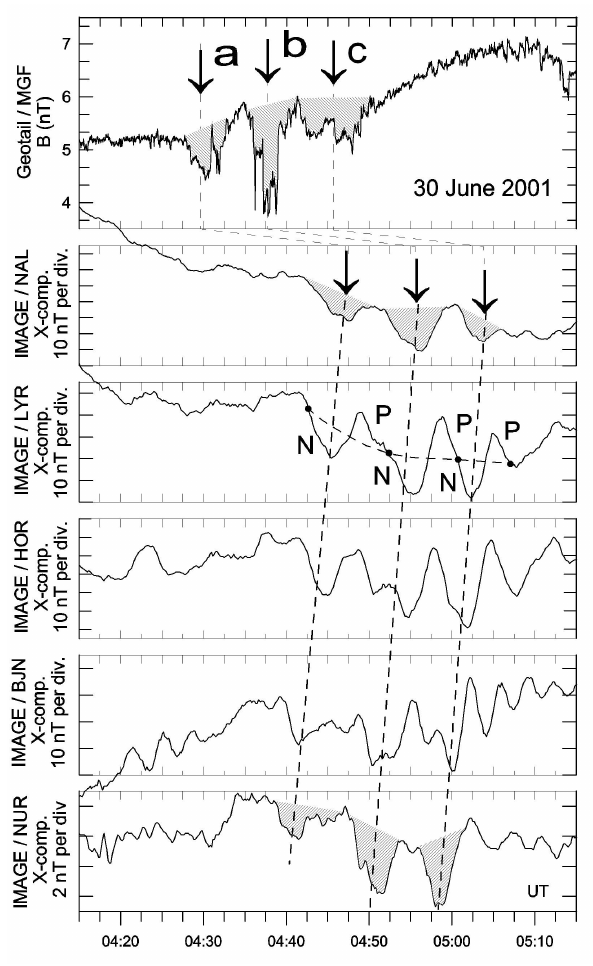
Fig. 1. Three major depressions (labelled ( a ) , ( b ) , and ( c ) ) seen along the solar wind magnetic field magnitude trace are associated with distinct ground signatures indicating latitude-dependent delays in arrival time. The shaded areas and the thick-dashed lines facili- tate the recognition of the dispersive